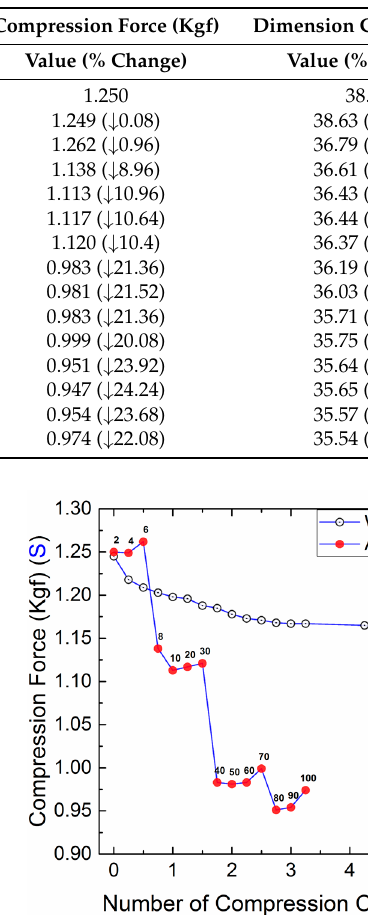
Table 1. Compression force and dimension change results of the clip component in comparison with number of autoclave cycles and test sample’s hardness measurement.